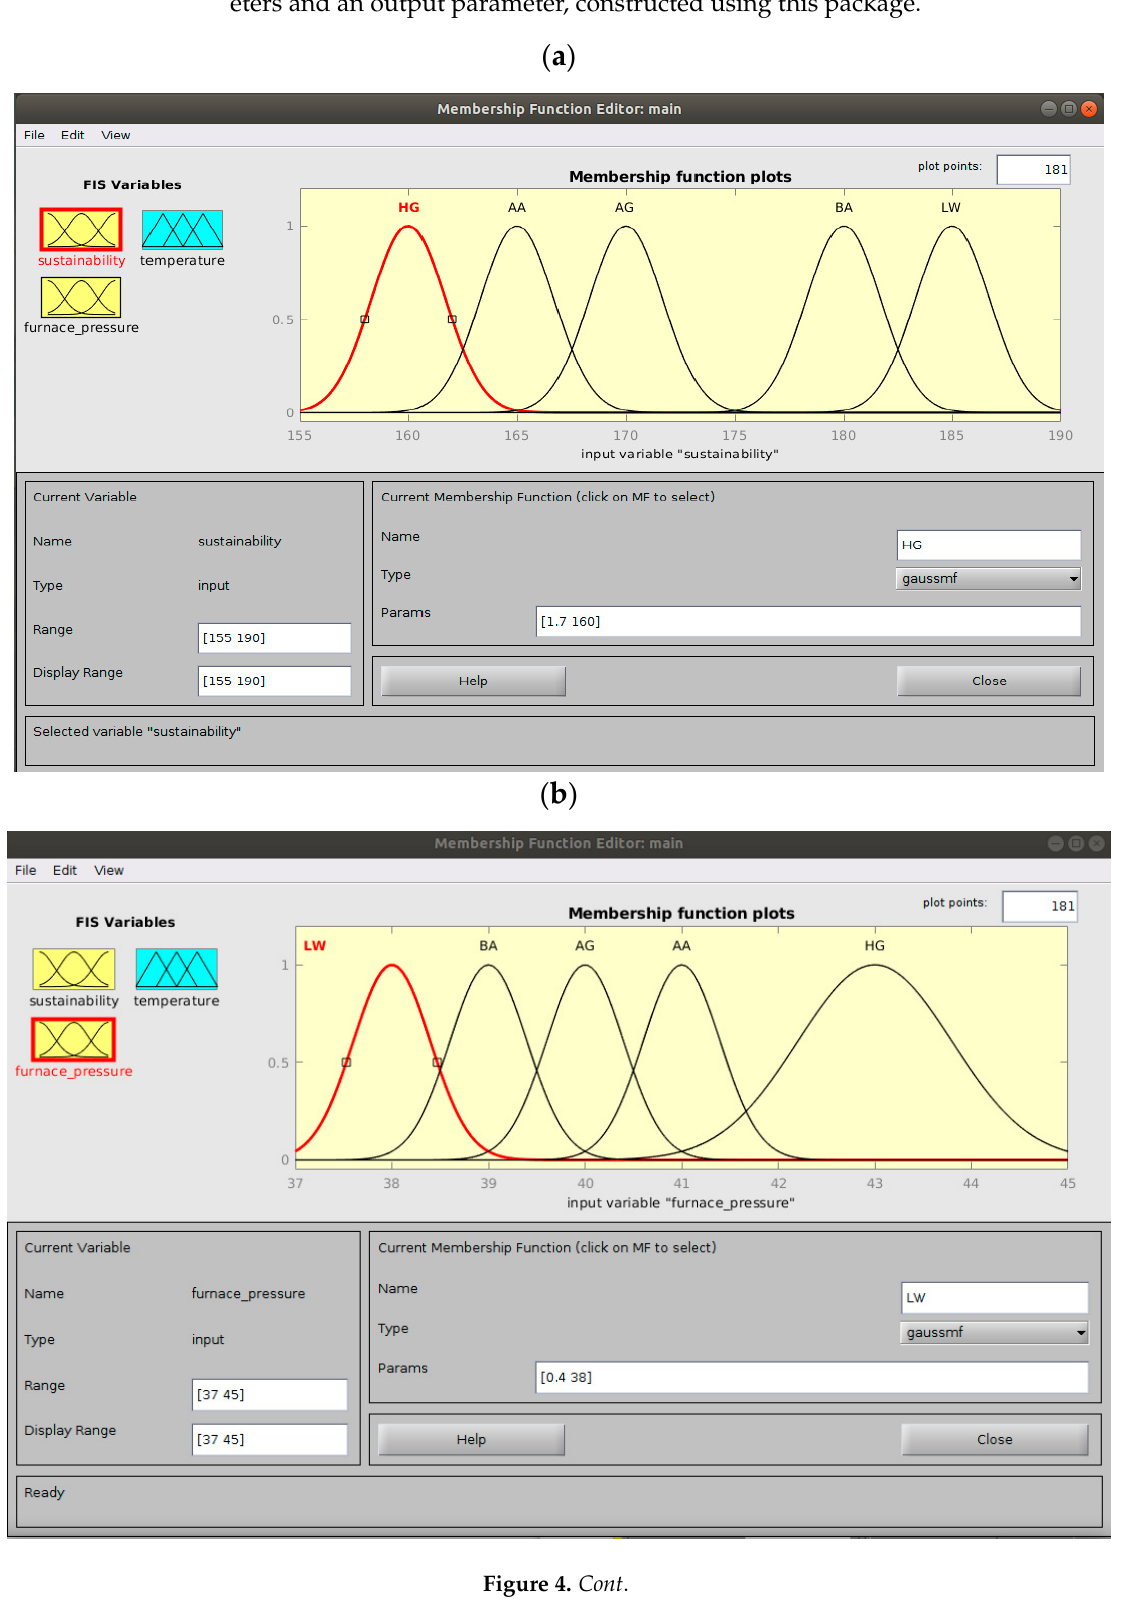
Figure 4a–c shows the Gausto-type membership functions for two fuzzy input param- eters and an output parameter, constructed using this package.